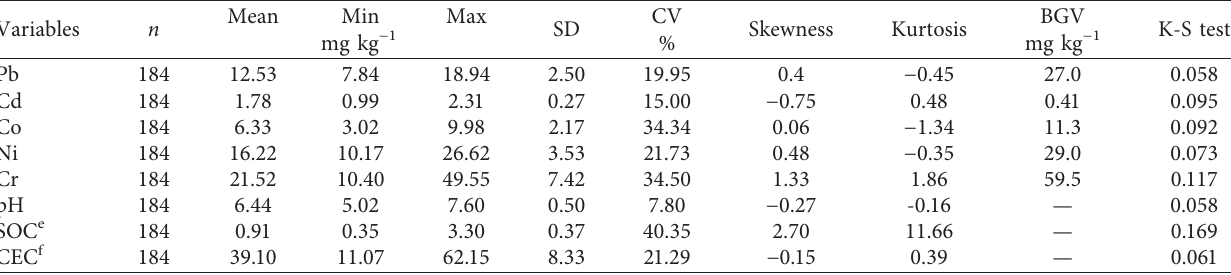
Table 1: Statistical analysis results of heavy metal concentrations in the soil of shallot fields in Brebes Regency, Central Java Province, Indonesia.